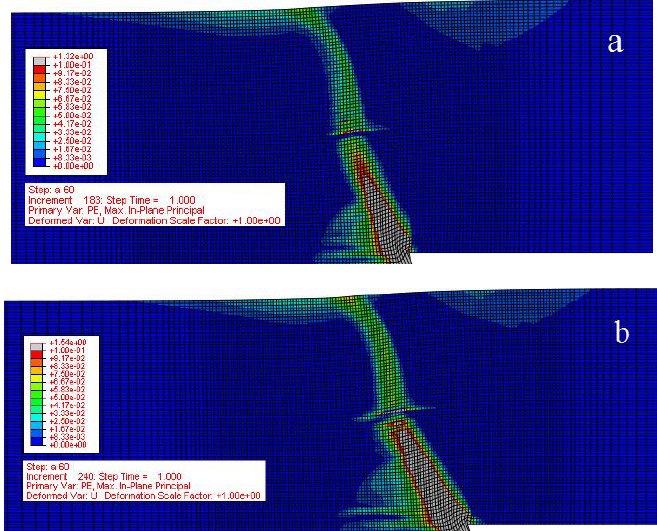
Fig. 9. Comparison of fault route for two-layer model: (a) LS-MS and (b)